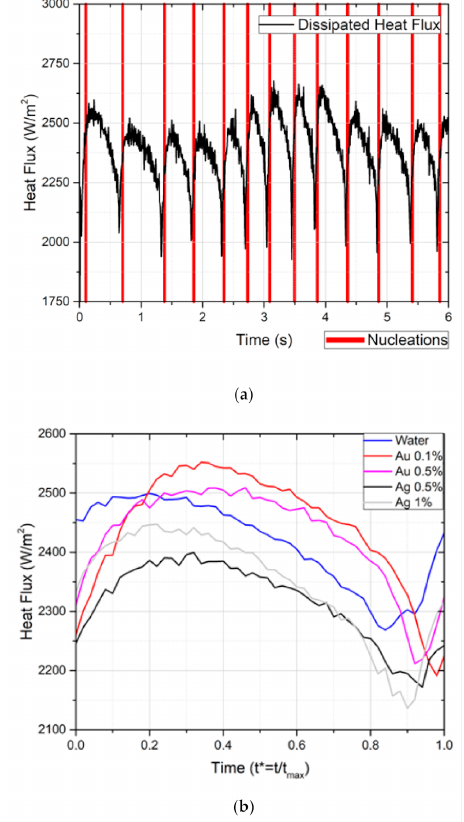
Figure 7. ( a ) Measured dissipated heat flux during pool boiling for a single bubble analysis of Ag 1 wt%, synchronized with the bubble departure events (red vertical lines). The imposed heat flux is 2132 W/m 2 . ( b ) Temporal evolution of the heat flux averaged from all the bubble events characterized in ( a